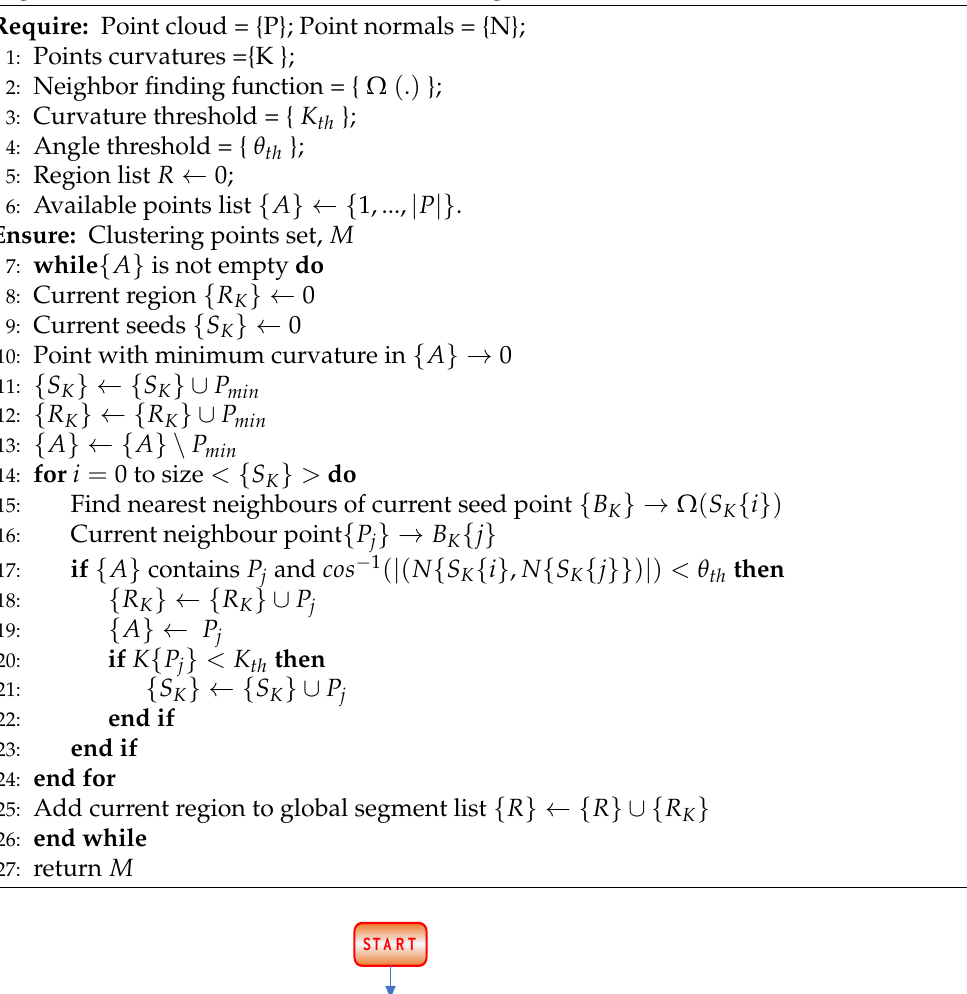
Algorithm 1 : The Point Cloud Extraction Algorithm for Ski Tracks